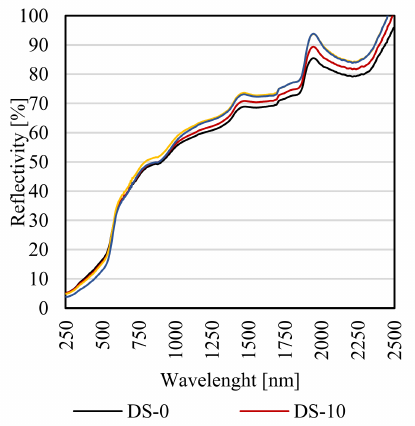
Figure 7. Visual inter-brick comparison of the nominal values of spectral